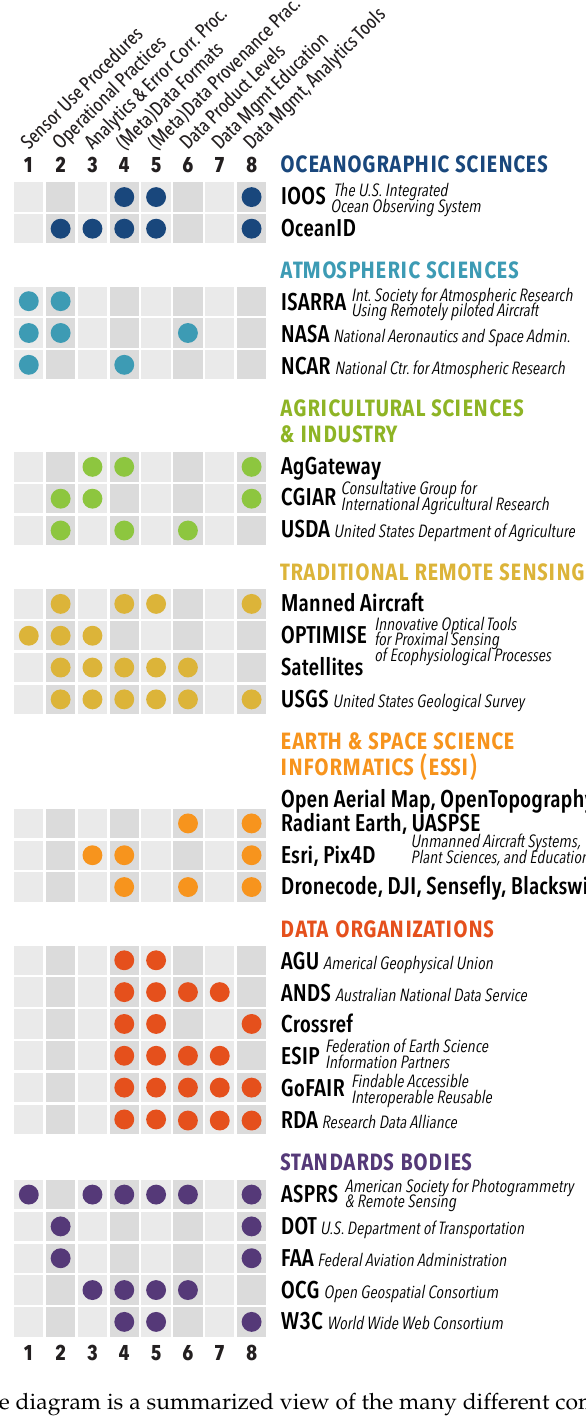
Figure 3. The above diagram is a summarized view of the many different communities the authors have interacted with in considering sUAS data management. Additionally, it calls out the eight key challenges to sUAS data management that this paper highlights. These eight challenges are discussed in detail in Section 3, but are listed here in order to identify primary sources for engagement. Each community, organization, and field listed here has called out these challenges through reports, papers, posters, conference sessions, community calls, and a multitude of informal conversations at various meetings, flying fields, and hallways. The grouping by discipline or role is an indication of the context within which this effort engaged with each; but in many cases these communities and organizations are contributing to multiple fields and act in multiple